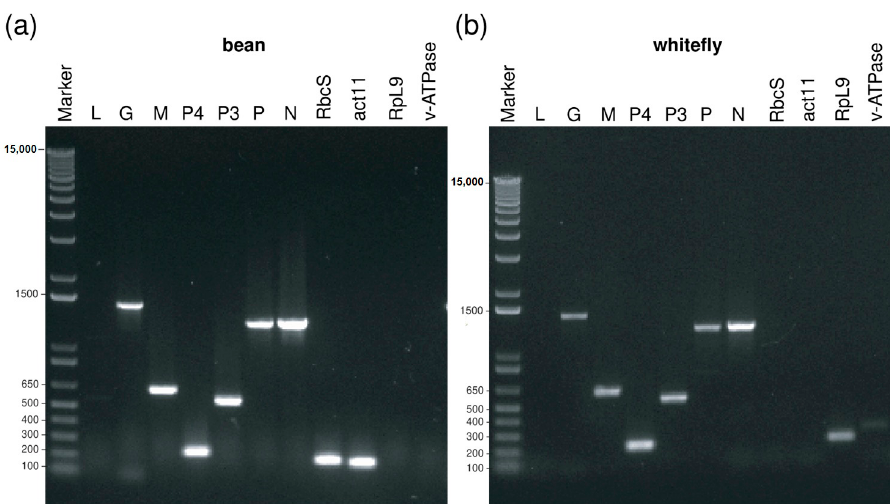
Figure 8. BaCV detection in common bean leaf and whiteflies ( B. tabaci MEAM1). BaCV RNA corresponding to G, M, P4, P3, P, N genes were detected by PCR using specific primers. Internal controls include the plant RbcS and act11 and the whitefly RpL9 and v-ATPase . ( a ) RT-PCR products obtained from RNA extracted from common bean. ( b ) RT-PCR products obtained from RNA extracted from viruliferous whiteflies.